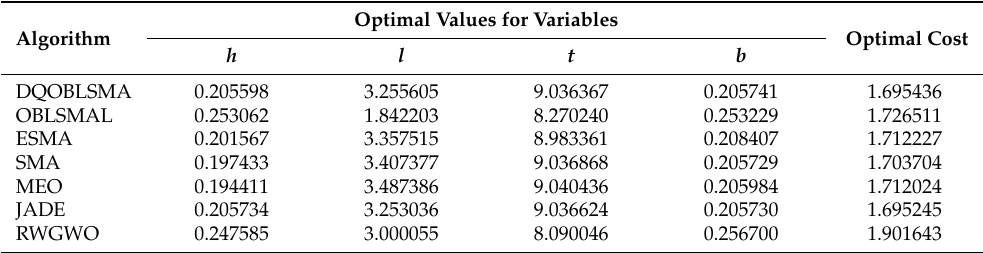
Table 11. Comparison in welded beam